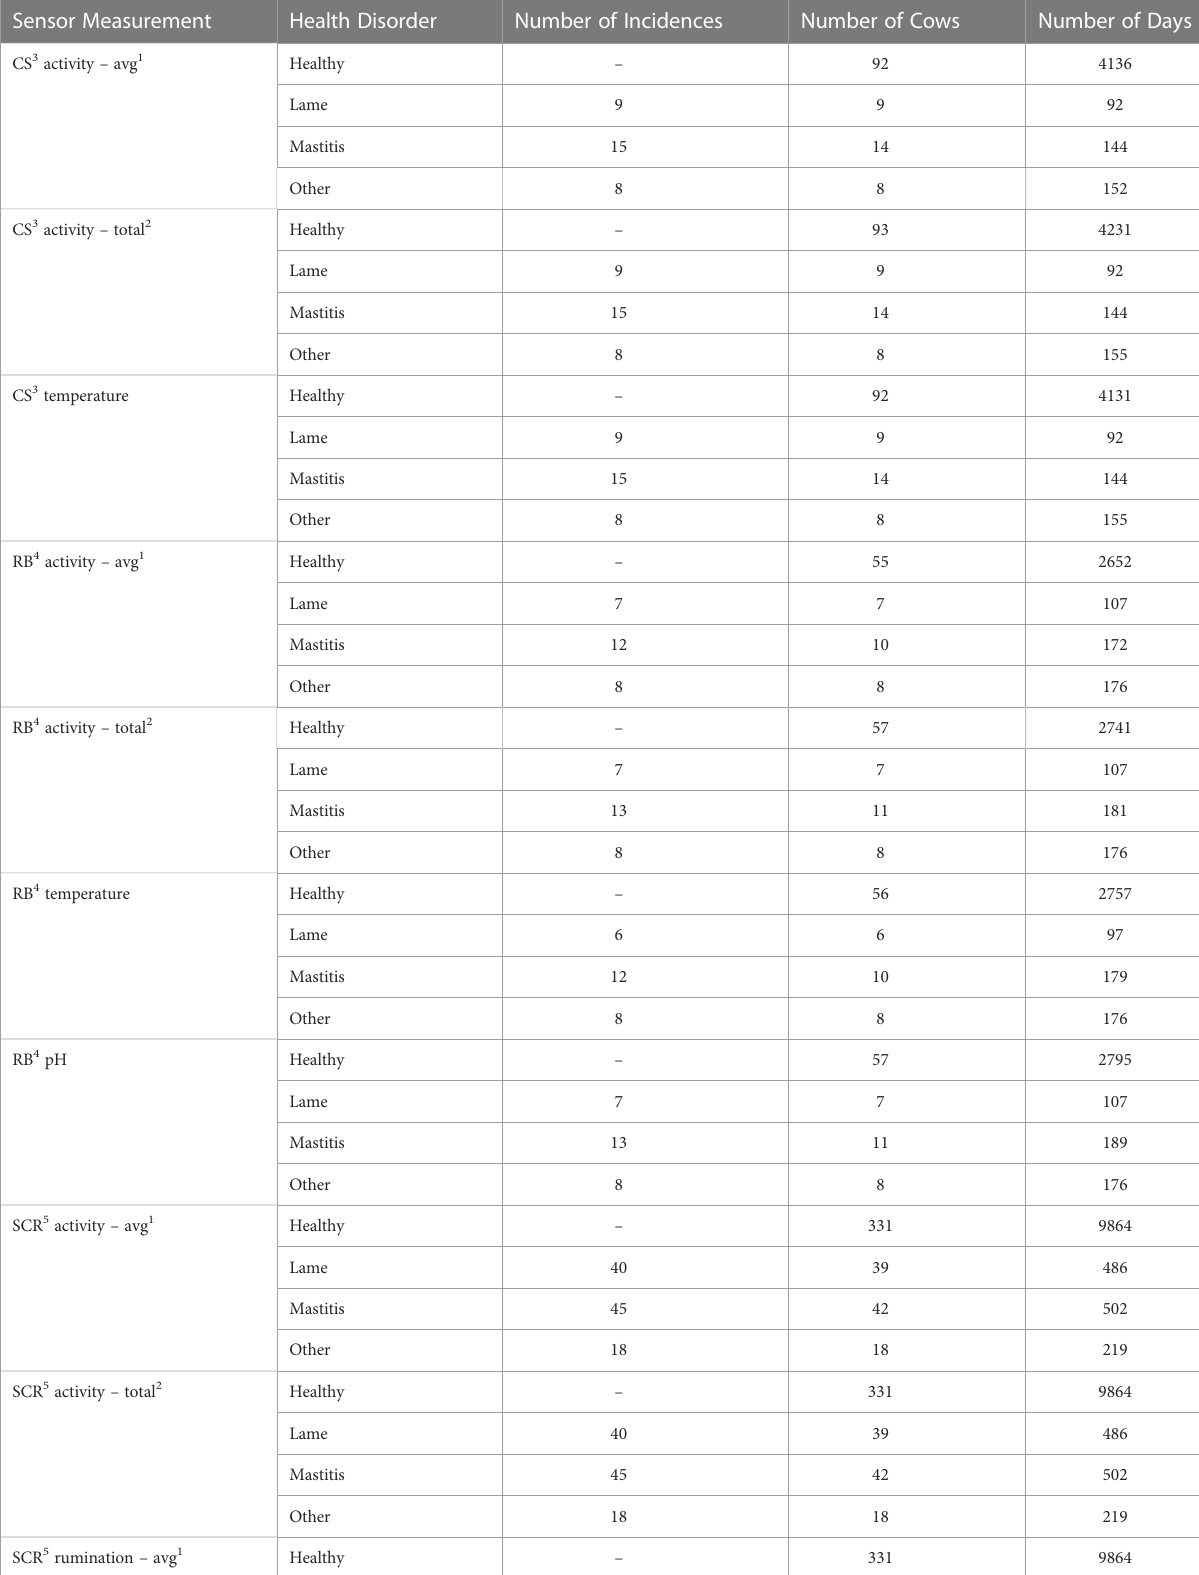
TABLE 2 Summary of health disorders available for datasets including automated sensor